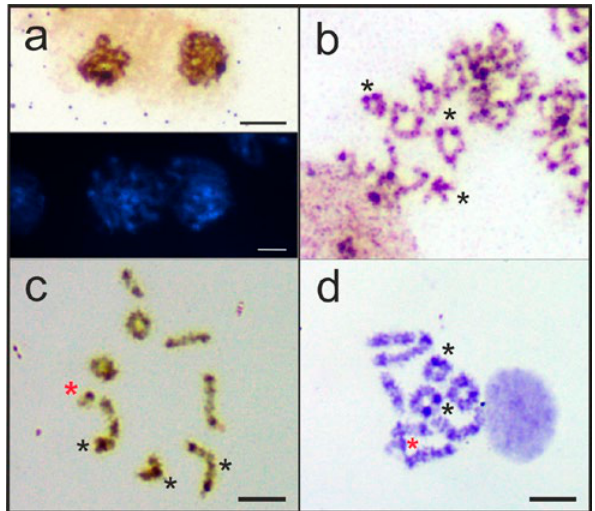
Fig. 4. NORs and heterochromatin in (a) Prophase I nuclei (silver and DAPI staining), (b) Diplotene-diakinesis, (c-d) pachytene after Silver (b-c) and Giemsa staining (d). Red asterisk indicate Xy p and the presence of obvious signal in the long arm telomeric region of submetacentric X, black asterisks show differentially stained chro- mosome regions. Bars = 5μm (b-c possess the same scaling).